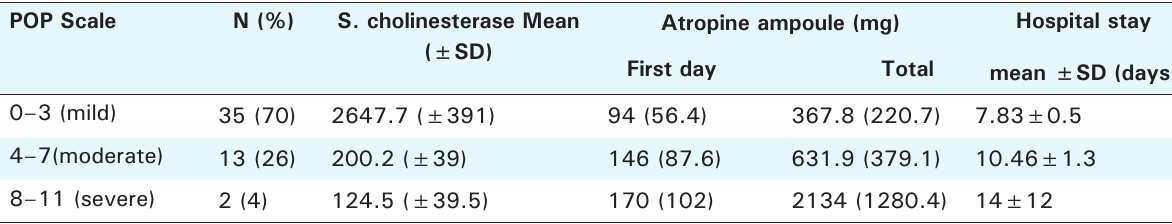
table 3. correlations between different parameters of the patients Parameters Pearson correlation (r) P value POP and serum cholinesterase –0.669† POP and hospital stay 0.414† POP and starting-dose atropine 0.474† POP and total atropine 0.537† <0.001 Serum cholinesterase and hospital stay –0.351* Serum cholinesterase and starting-dose atropine –0.341* Serum cholinesterase and total atropine –0.318* Hospital stay and starting-dose atropine 0.506† Hospital stay and total atropine 0.788† Starting-dose atropine and total atropine 0.751† *Correlation is significant at the 0.05 level (2 tailed),†Correlation is significant at the 0.01 level (2 tailed).